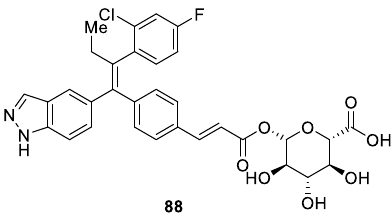
Figure 10. Chemical structures of 3-(pyrrolopyridin-2-yl)indazole derivatives 91 , 92 and 93. Pauls et al. [54] synthesized a new set of 3-(4-(heterocyclyl)phenyl)-1 H -indazole-5- carboxamides derivatives, which were tested as inhibitors of tyrosine threonine kinase (TTK). It was found that compounds 94 , 95 (designated CFI-401870) and 96 were single-digit nanomolar TTK inhibitors, with acceptable off-target activity and good oral bioavailability in rodents (Figure 11). In particular, compound 95 served as the most efficacious of the shortlisted compounds in an HCT116 tumor xenograft model, which also could inhibit the growth of a broad panel of human cancer cell lines including breast, ovarian, colon, prostate, lung and melanoma cell lines. Figure 11. Chemical structures of 3-(4-(heterocyclyl)phenyl)-1 H -indazole-5-carboxamides derivatives 94 , 95 and 96. Qu et al. [55] performed anticancer activities screening assays as well as cancer growth inhibitory studies